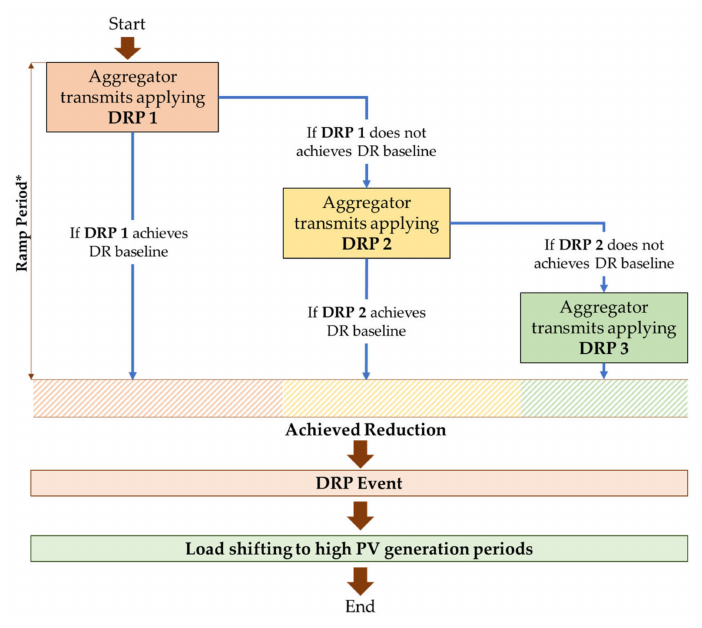
Figure 3. Ramp period evaluation process by the aggregator.